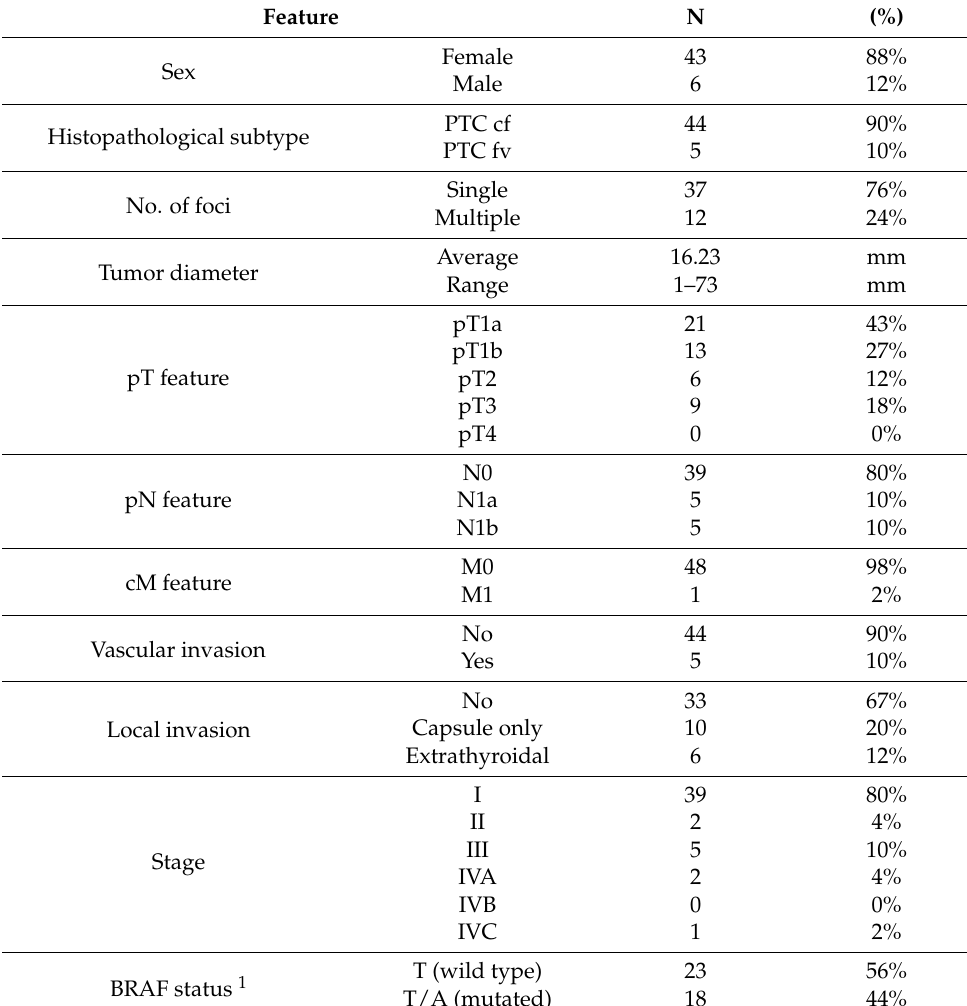
Table 1. Characteristic of PTC